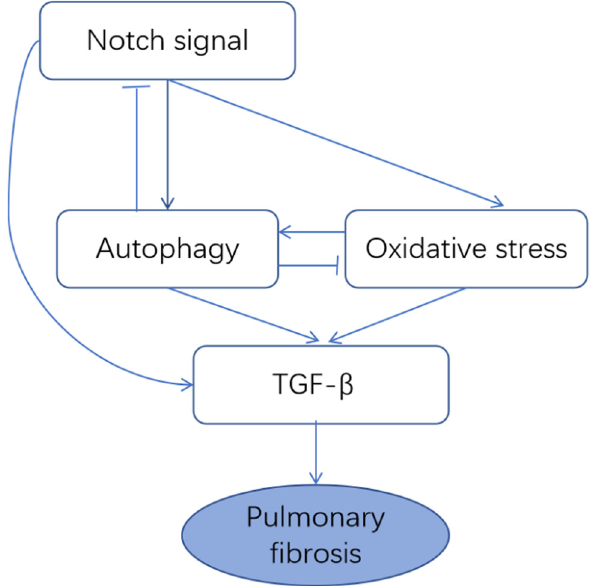
Figure 9: Hypothesis for the mechanism of Notch signaling pathway - mediated autophagy involvement in pulmonary fi